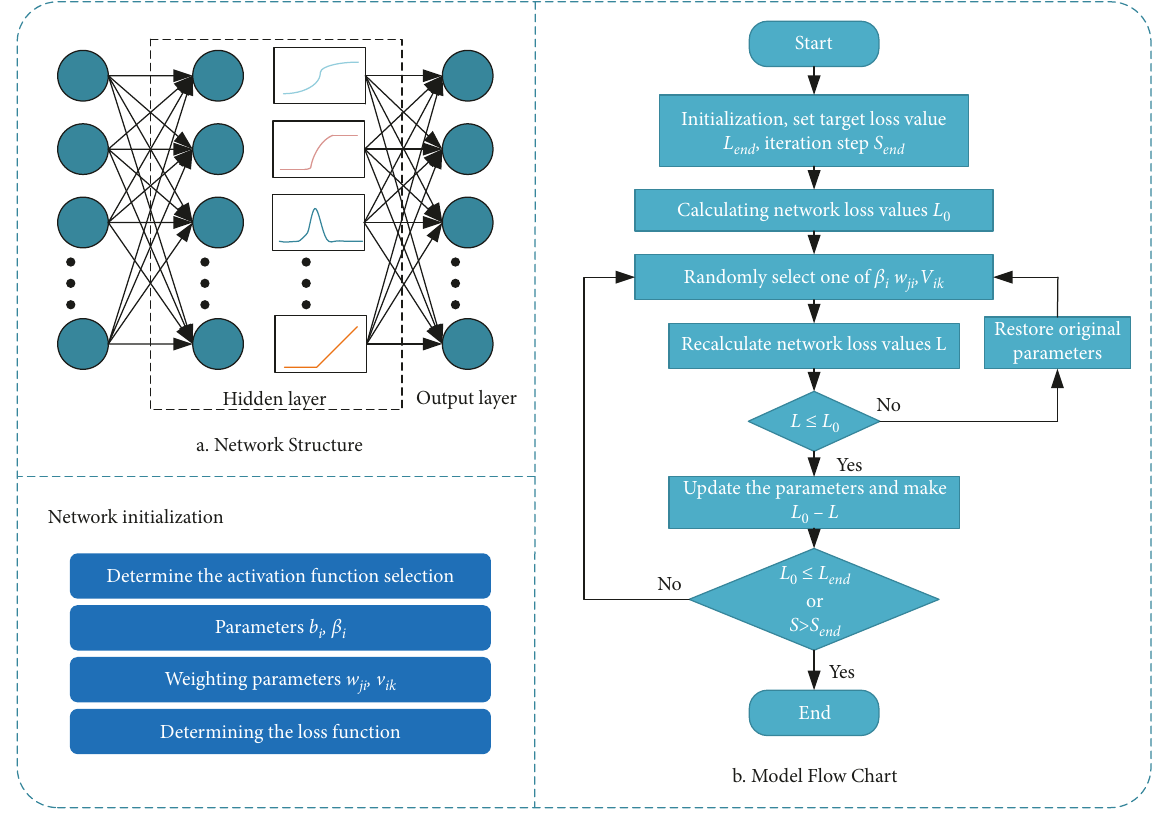
Figure 2: A Monte Carlo method based on neural